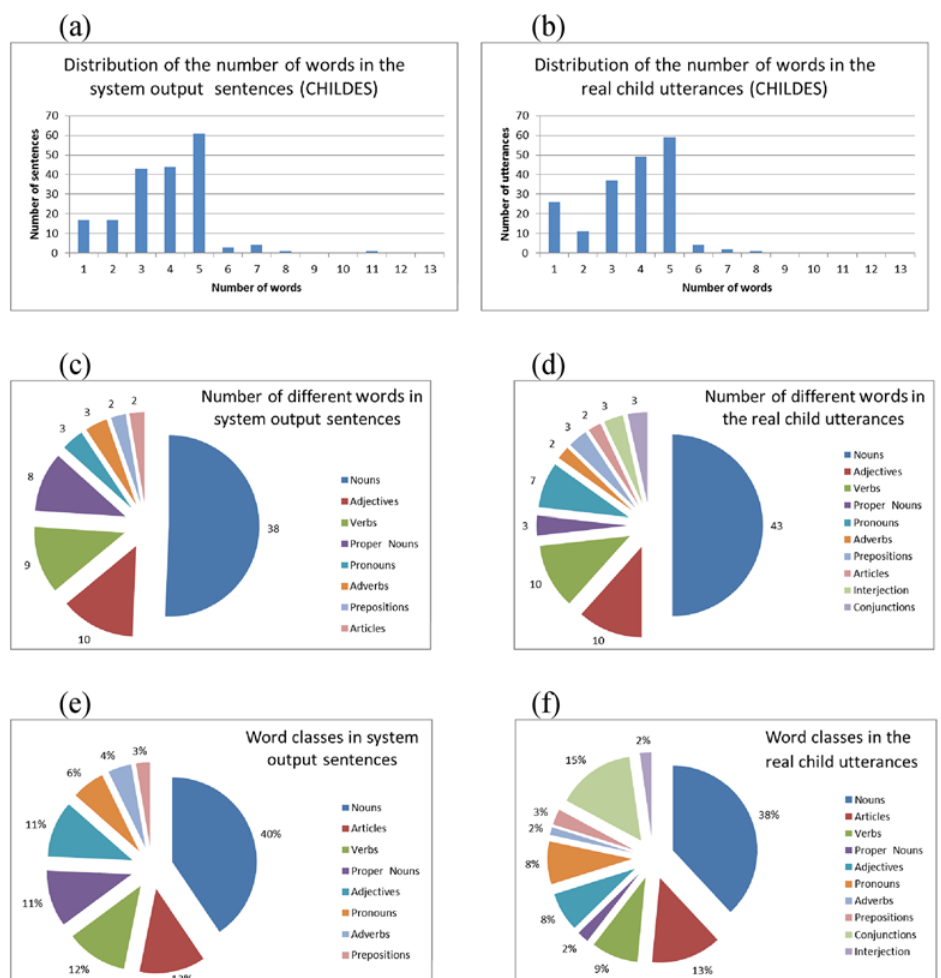
Fig 10. Comparison between some distributions related to the output sentences produced by the system in the communicative interaction test, based on the Warren-Leubecker corpus from the CHILDES database, and to the utterances of the real child for the same part of the corpus: distribution of the number of words in the output sentences (a,b); distribution of the words used in the output sentences among different word classes (c,d); percentage of word classes in the output sentences